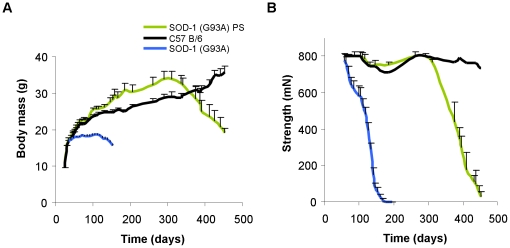
Weight loss and muscular strength deficit are delayed in the SOD-1 PS line.(A) The SOD-1 (G93A)PS mice (n = 8) have a delayed onset of weight decrease when compared to the original line (n = 17) (p<0.05). (B) Normal SOD-1 Tg mice start with a decrease in muscle strength at the age of 70 days. SOD-1 (G93A)PS mice have normal muscular strength until the age of 310 days (p<0.05).